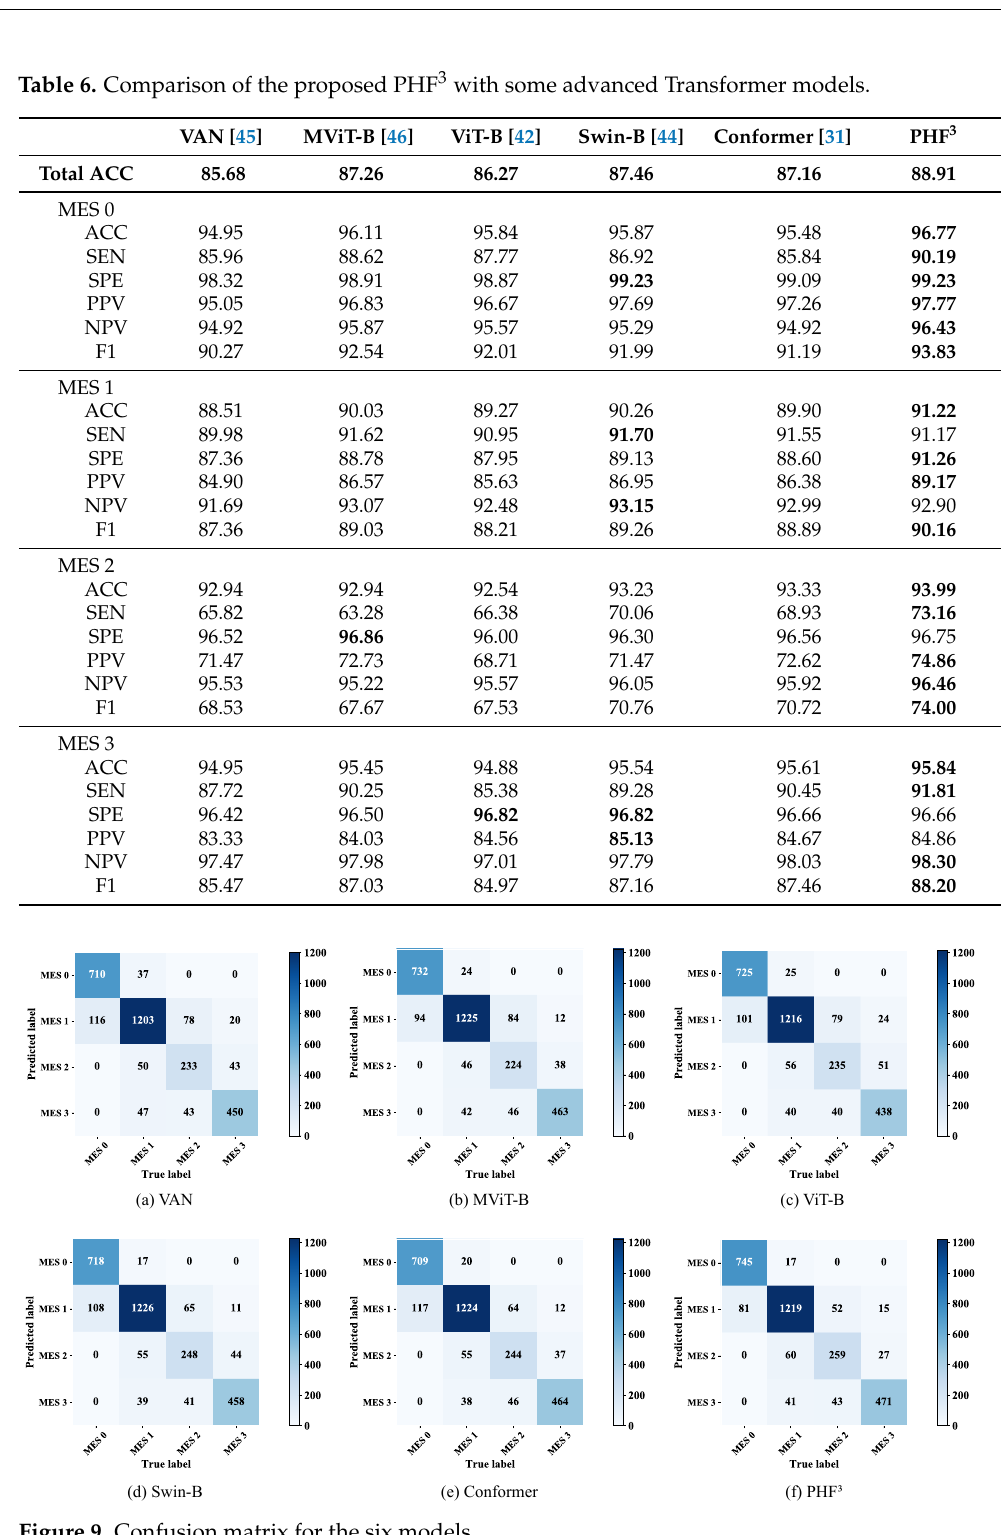
Figure 9. Confusion matrix for the six